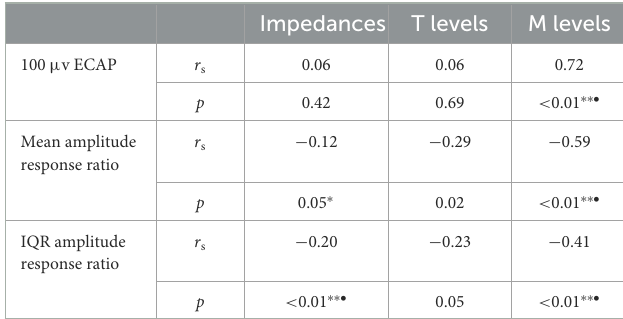
TABLE 4 Spearman correlation analysis showing relationships between ECAP outcomes and both impedances and stimulation